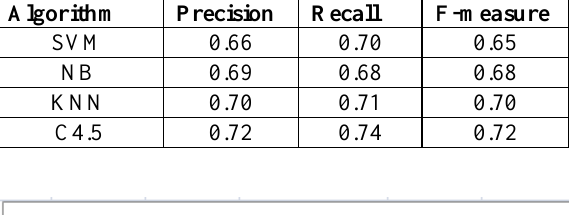
Table 13. Comparison of prediction results of various